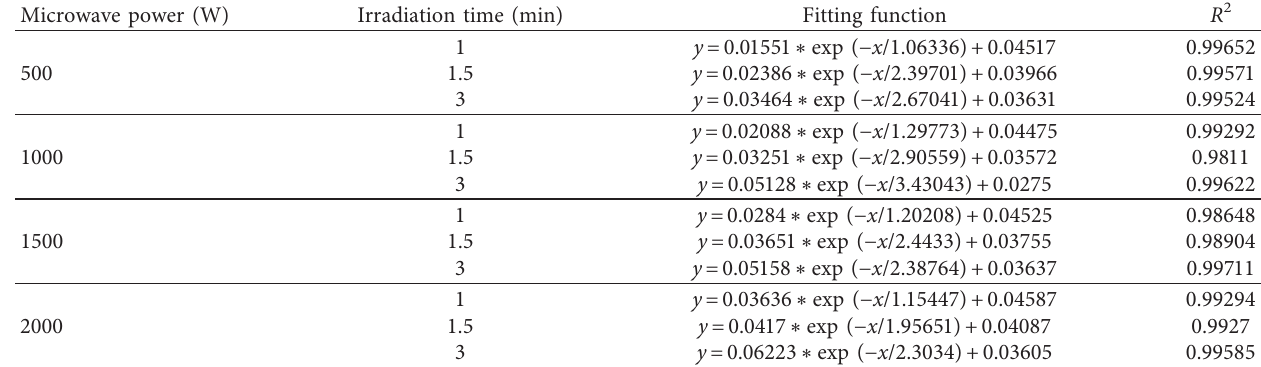
Table 4: Fitting results for permeability under a confining pressure of 4MPa.